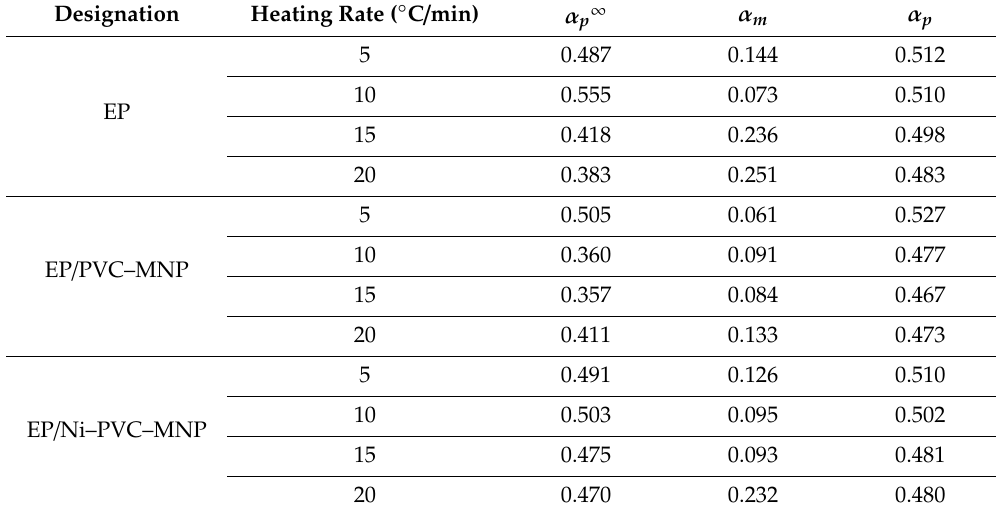
Table 3. Values of Malek parameters for the studied